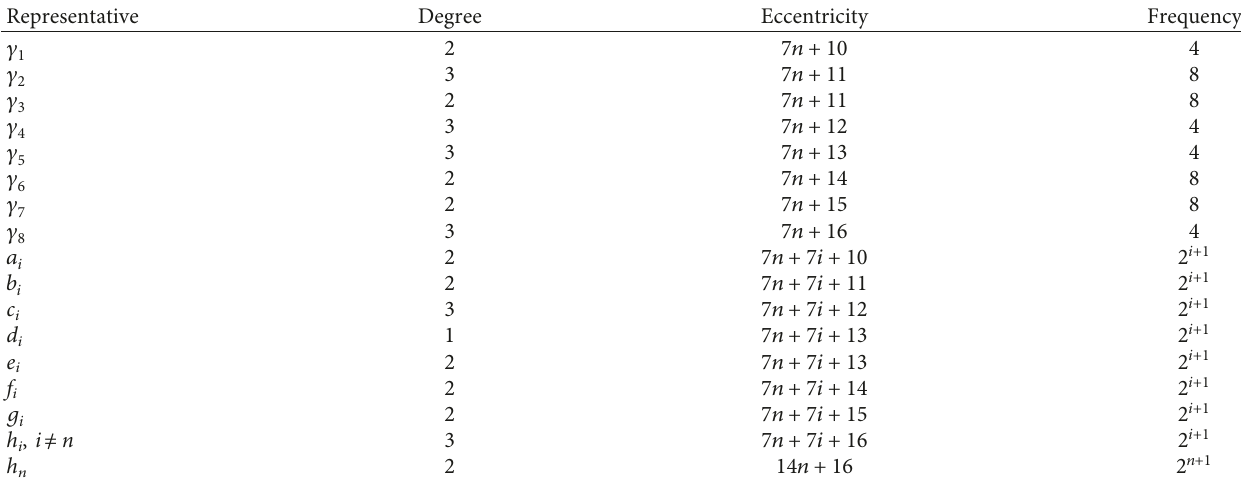
Table 2: Vertex representatives for P Representative